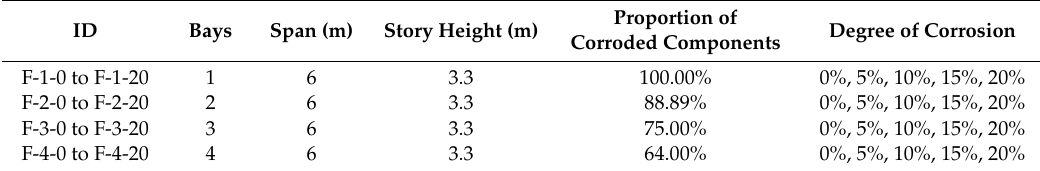
Table 2. Parameters of simulation